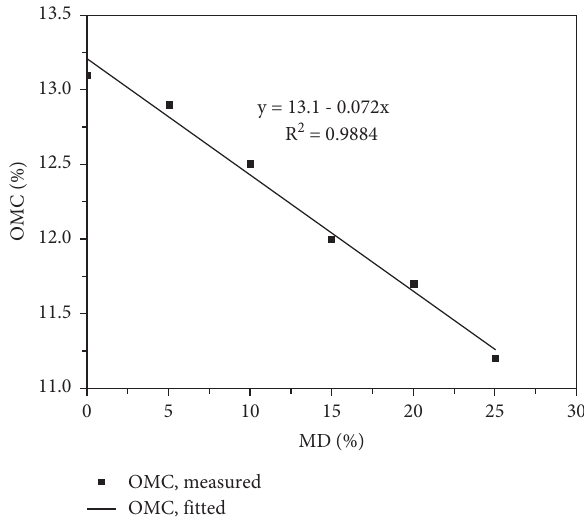
Figure 9: Variation of OMC with the percentage of